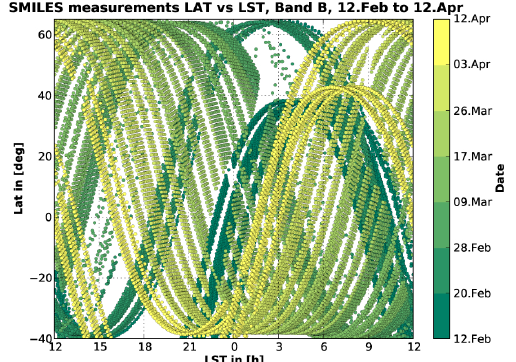
Fig. 25. SMILES measurement locations plotted with respect to lat- itude and local solar time (LST) over a two month period. The col- oring indicates the date when a profile was measured.